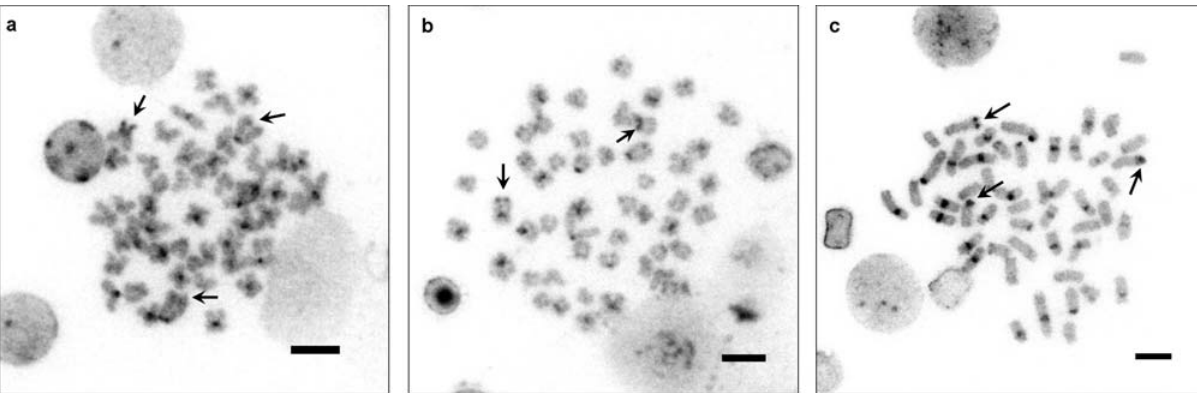
Figure 4 - C-banding in metaphases of Iberochondrostoma lusitanicum : ( a ) Samarra, female, one pair of A chromosomes with terminal heterochromatin and one SM with a whole heterochromatic short arm; ( b ) Tejo2, male, one SM with a terminal block of heterochromatin and one SM with a whole heterochromaticshortarm;( c )Tejo1,female,onepairofSMwithterminalheterochromatinandoneSMwithawholeheterochromaticshortarm.Arrows indicate the heterochromatic blocks. The bar corresponds to 5 (cid:2) m.